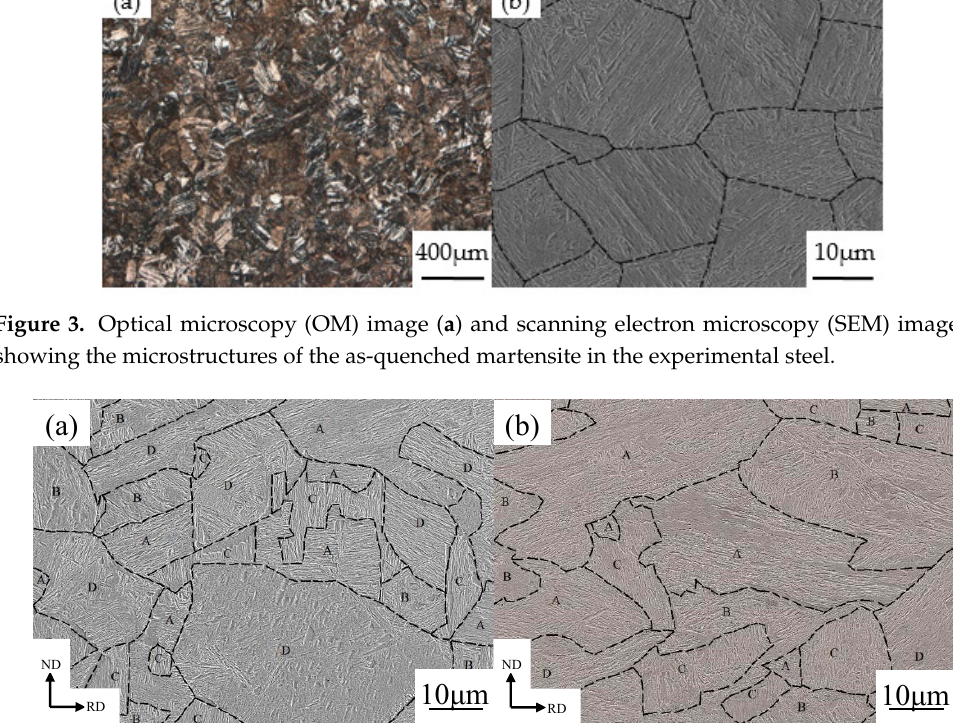
Figure 4. SEM images showing the microstructures of the experimental steel cold-rolled to a reduction of 10% ( a ) and 30% ( b ). The initial microstructure was martensite. Alphabetic characters denote which type of microstructure is exhibited. A, lamellar dislocation cell (LDC); B, irregularly bent lath (IBL); C, kinked lath (KL); D, lath martensite (M)).